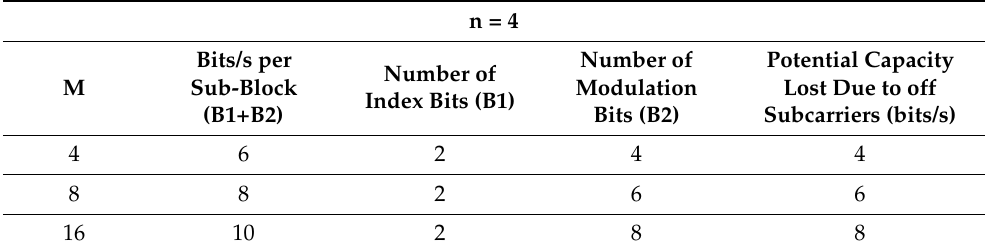
Table 6. Distribution of bits between B1 and B2.